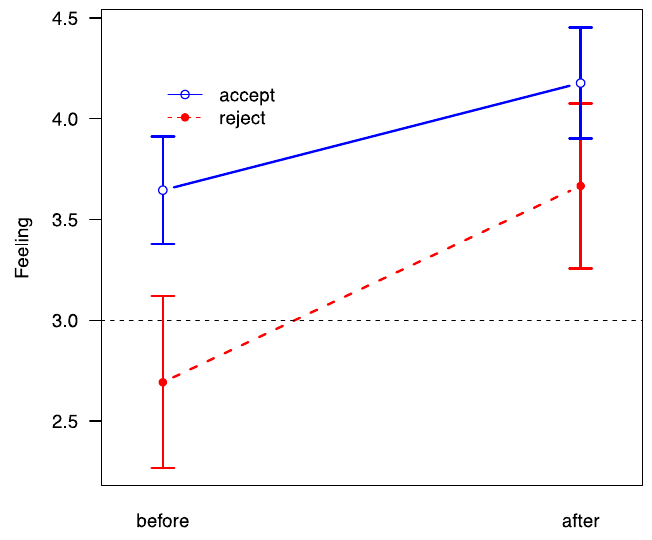
Figure 3. Study 2: General feeling (0 = very bad, 6 = very good) before and after the choice to accept or reject. Error bars indicate 95%